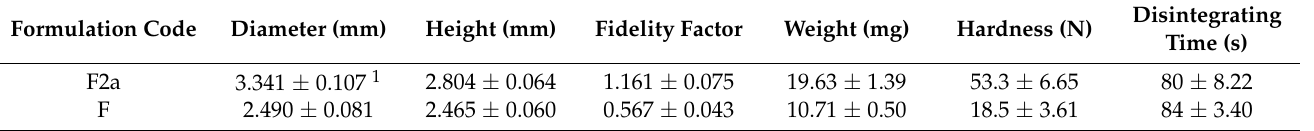
Table 12. Characterisation results of F compared with